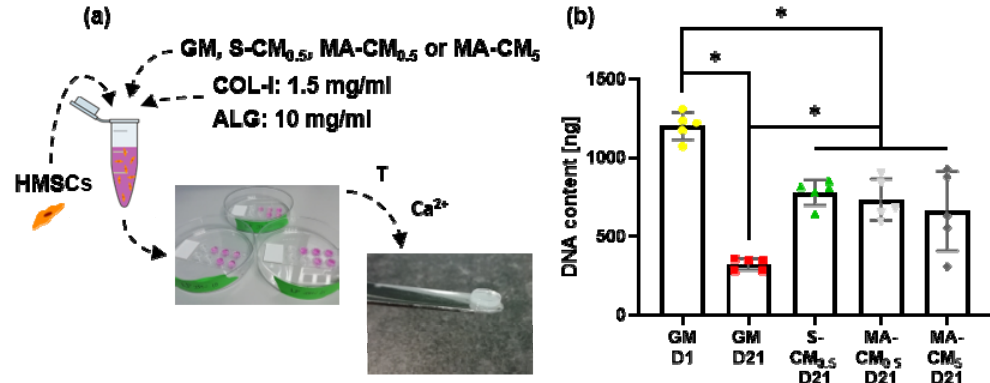
Figure 4. Effect of osteocyte derived paracrine factors on cell viability in IPN 10 hydrogels. ( a ) Schematic overview of the different media groups supplemented with 10% FBS and osteogenic factors including growth medium quantified at both day 1 and day 21 after incorporating the hMSCs into the IPN hydrogel (GM D1 and GM D21), Speedvac-concentrated static osteocyte conditioned medium diluted to a protein content of 0.5 mg/mL quantified at day 21 after hMSC incorporation (S-CM 0.5 D21), Speedvac-concentrated mechanically activated osteocyte conditioned medium diluted to a protein content of 0.5 mg/mL quantified at day 21 after hMSC incorporation (MA-CM 0.5 D21), and Speedvac-concentrated mechanically activated osteocyte conditioned medium diluted to a protein content of 5 mg/mL quantified at day 21 after hMSC incorporation (MA-CM 5 D21); ( b ) quantification of the DNA content through a picogreen dsDNA kit for the different media groups (n = 5).